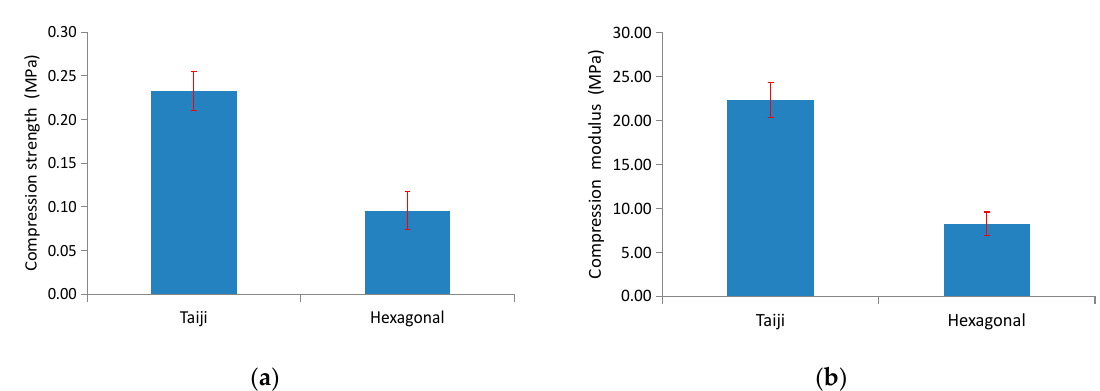
Figure 9. The properties of the Taiji honeycomb compared to the traditional hexagonal one: ( a ) compression strength; ( b ) compression modulus (l = 9.5 mm; A = 3.18 mm MDF; B = 25.4 mm; C = 0.5 mm / min; andvertical bar: error bar with standard deviation).